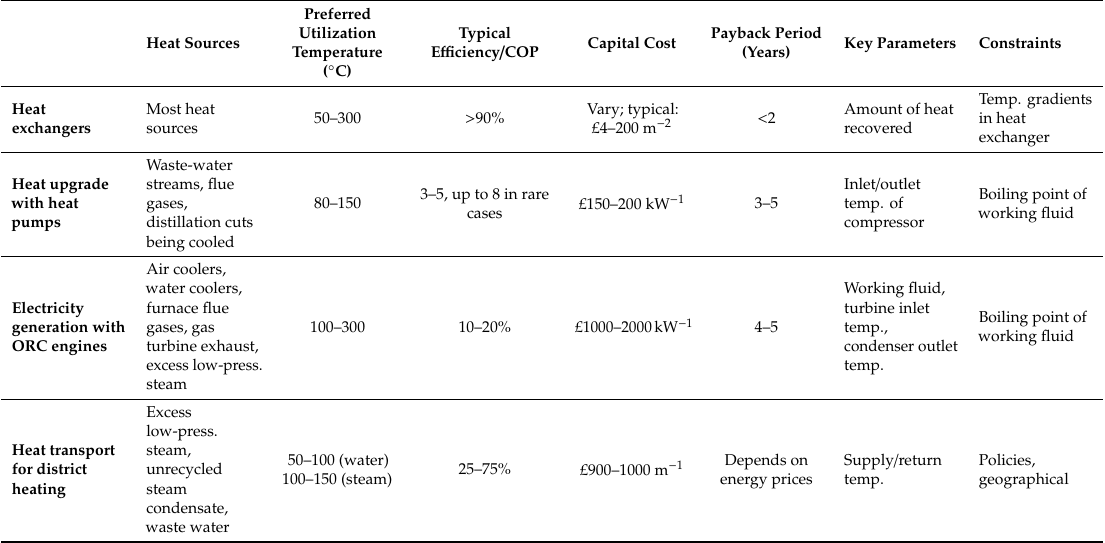
Table 4. Technologies for eat recovery. ORC: organic Rankine cycle; COP: coe ffi cient of